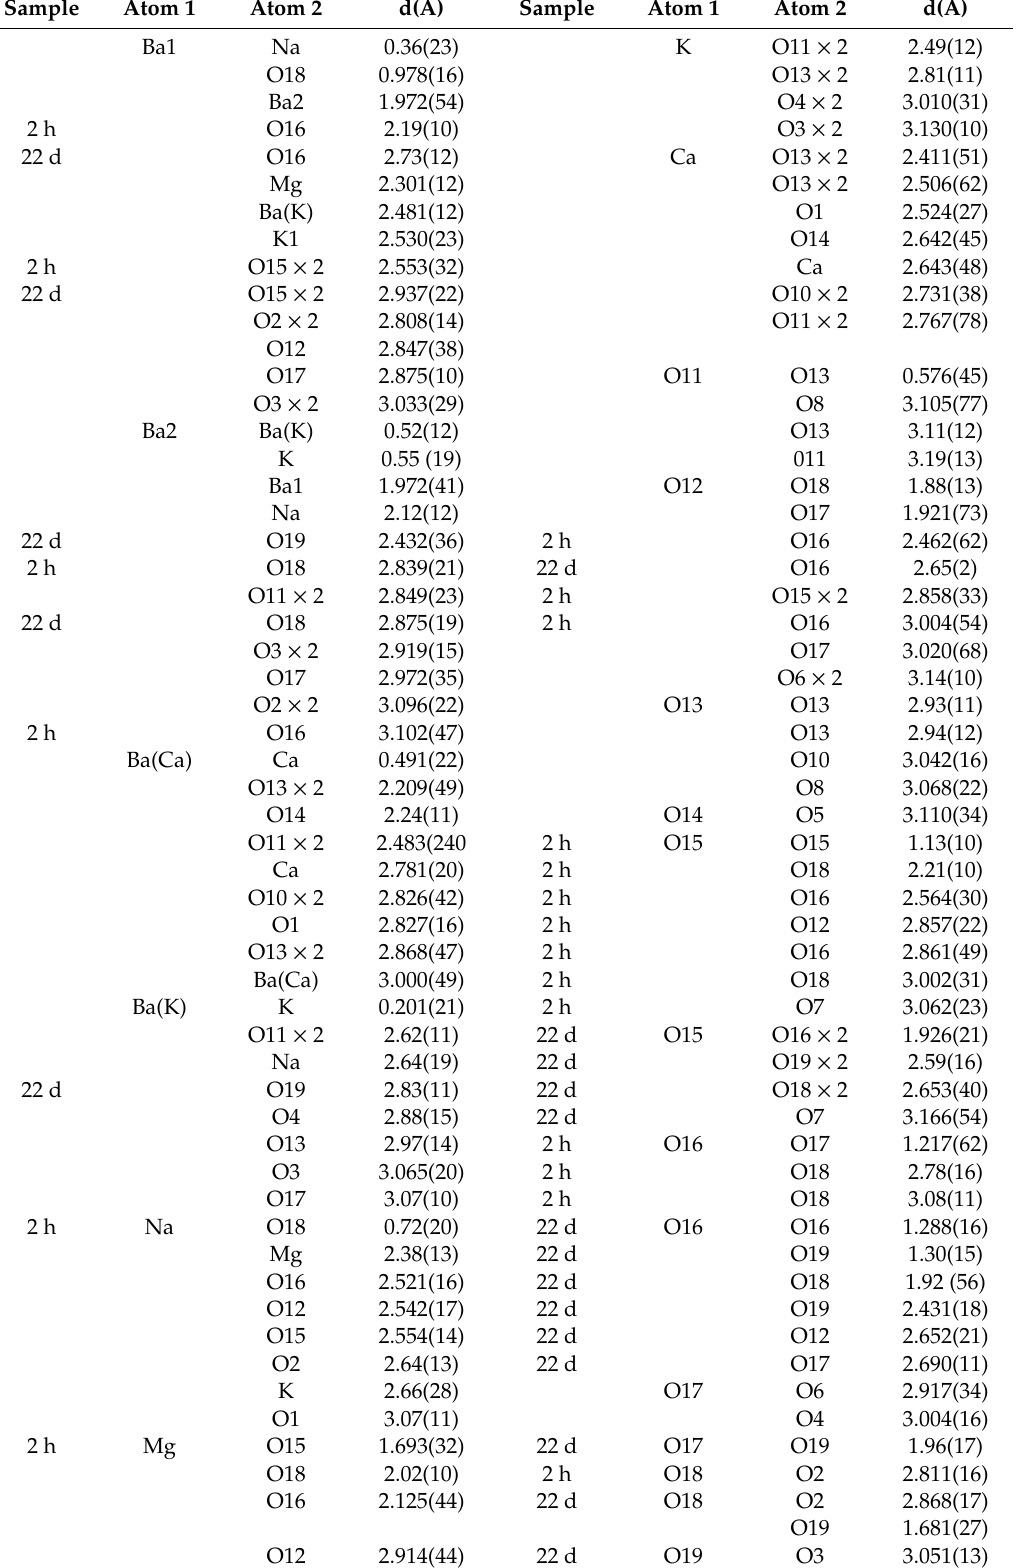
Table 6. Interatomic distances of the extra-framework cations and H 2 O molecules of samples Ba-clinoptilolite (90 ◦ C, 2 h) and Ba-clinoptilolite (90 ◦ C, 22 d) (nonindicated sample cells correspond to both